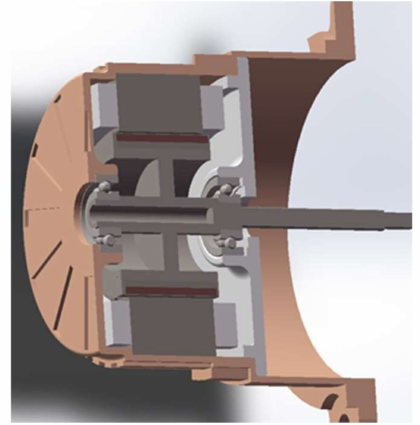
Figure 1. 3d internal structure of the PM